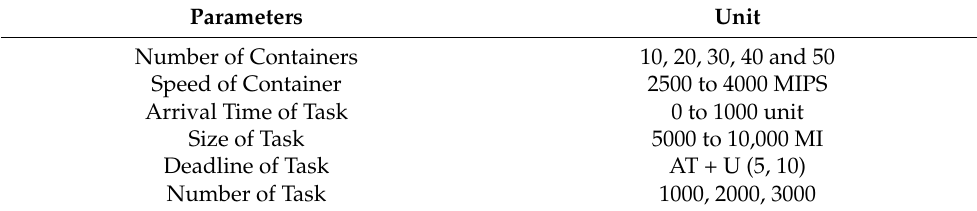
Table 5. Parameters Considered for the Proposed System Model.